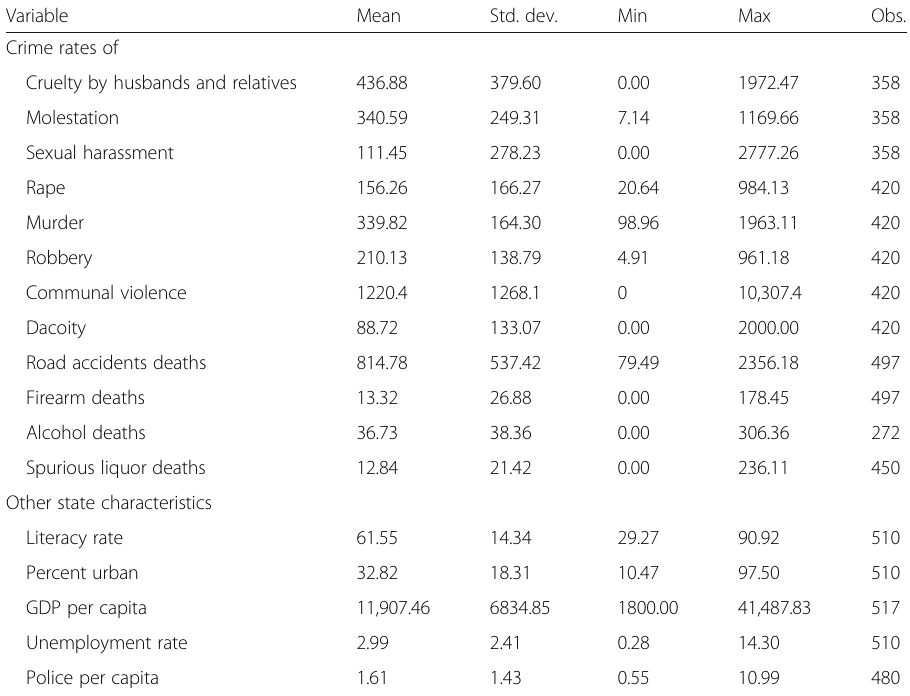
Table 2 Summary statistics of state-year panel data on crimes, mortality, and controls Variable Mean Std. dev. Min Max